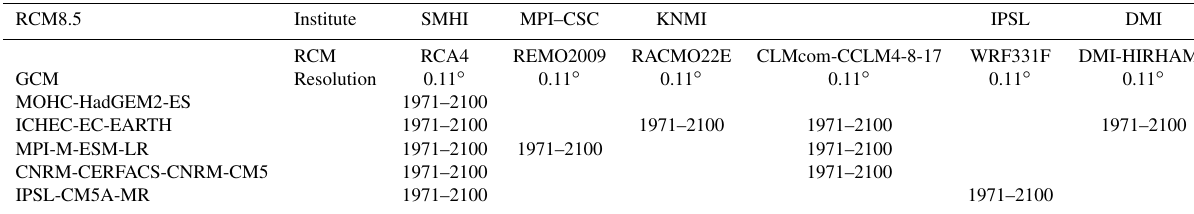
Table A3. CORDEX-EUR-11 simulation matrix for RCP8.5 used in the study. RCM8.5